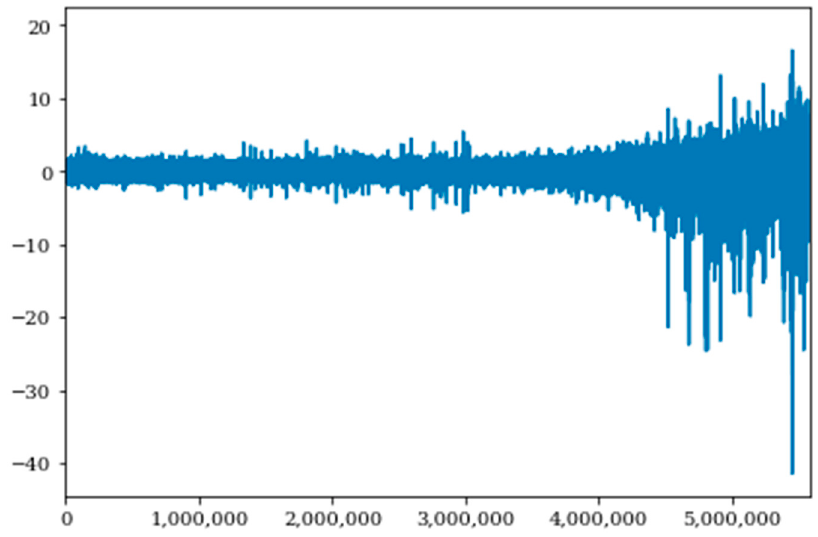
Figure 14. Raw Bearing 1-3 Data Signal Versus Time.